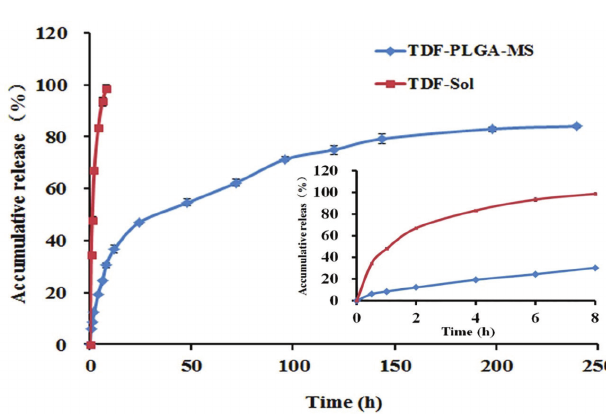
FIGURE 6 - In vitro release profile of TDF from TDF-PLGA- MS and TDF-Sol.